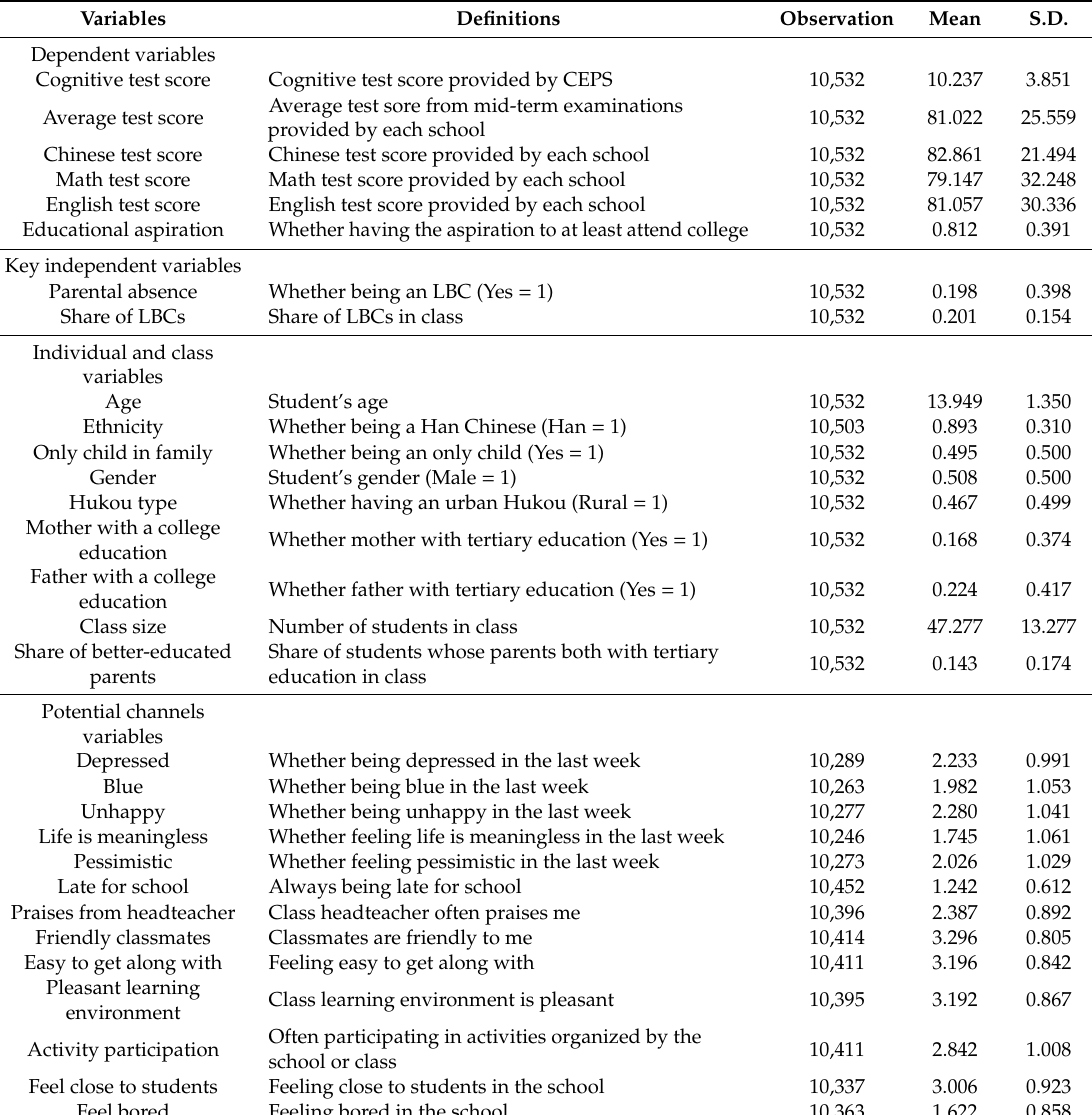
Table 1. Summary statistics of the